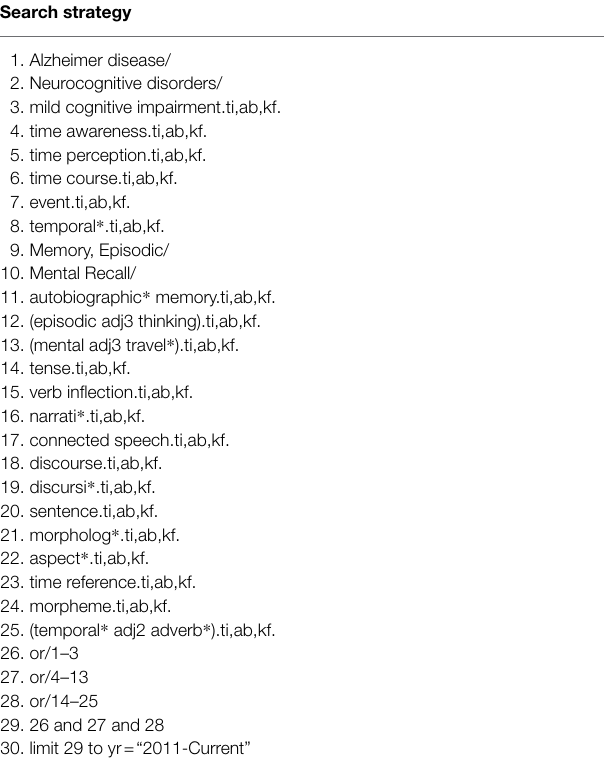
TABLE 1 | Search strategy applied via Ovid in Medline